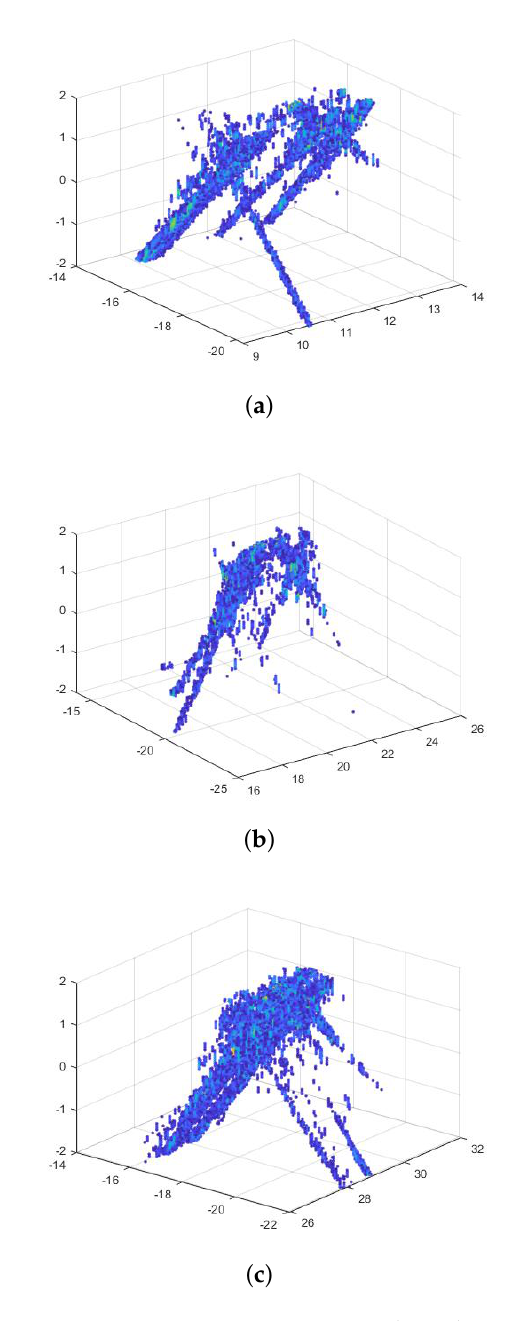
Figure 11. 3D imaging using 3D BP with single pass CSAR data. ( a ) 3D imaging result of Vehicle C. ( b ) 3D imaging result of Vehicle B. ( c ) 3D imaging result of Vehicle